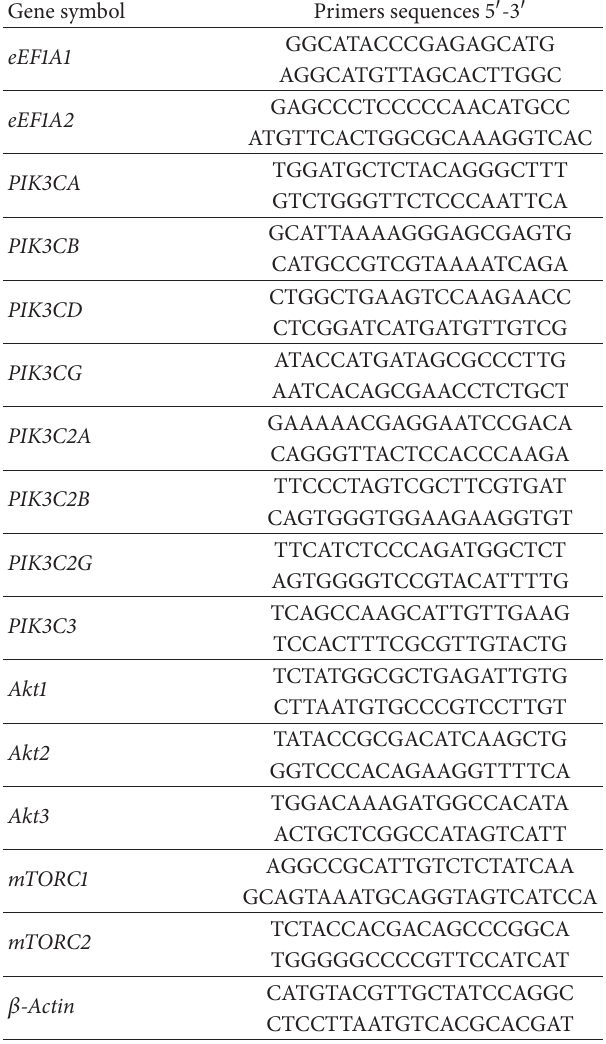
Table 1: List of primer pairs used for real-time quantitative